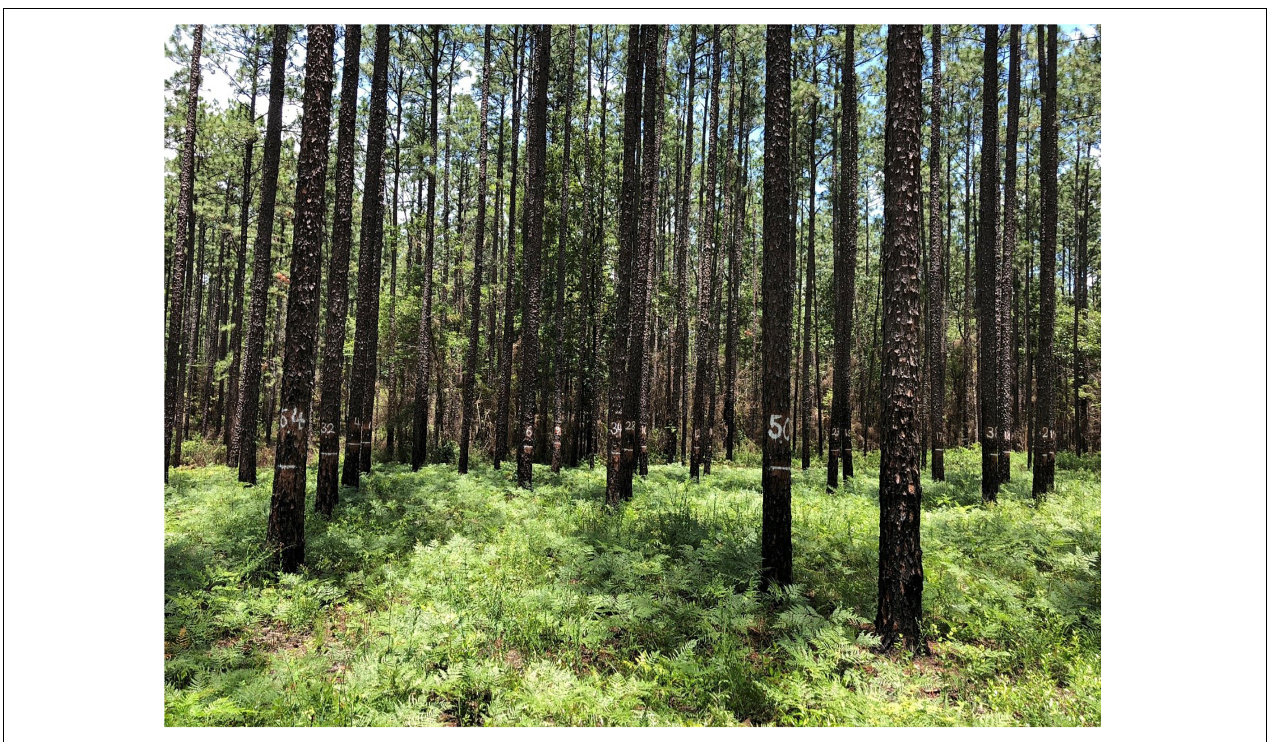
FIGURE 1 | An example of a 0.1 ha measurement plot in a winter biennial burn treatment. TABLE 1 | Results of mixed-effects analyses of variance (ANOVA) for the effect of seasonal biennial fire (winter, spring, summer) and the unburned treatment on longleaf pine diameter growth, height growth, volume growth, and survival. Response